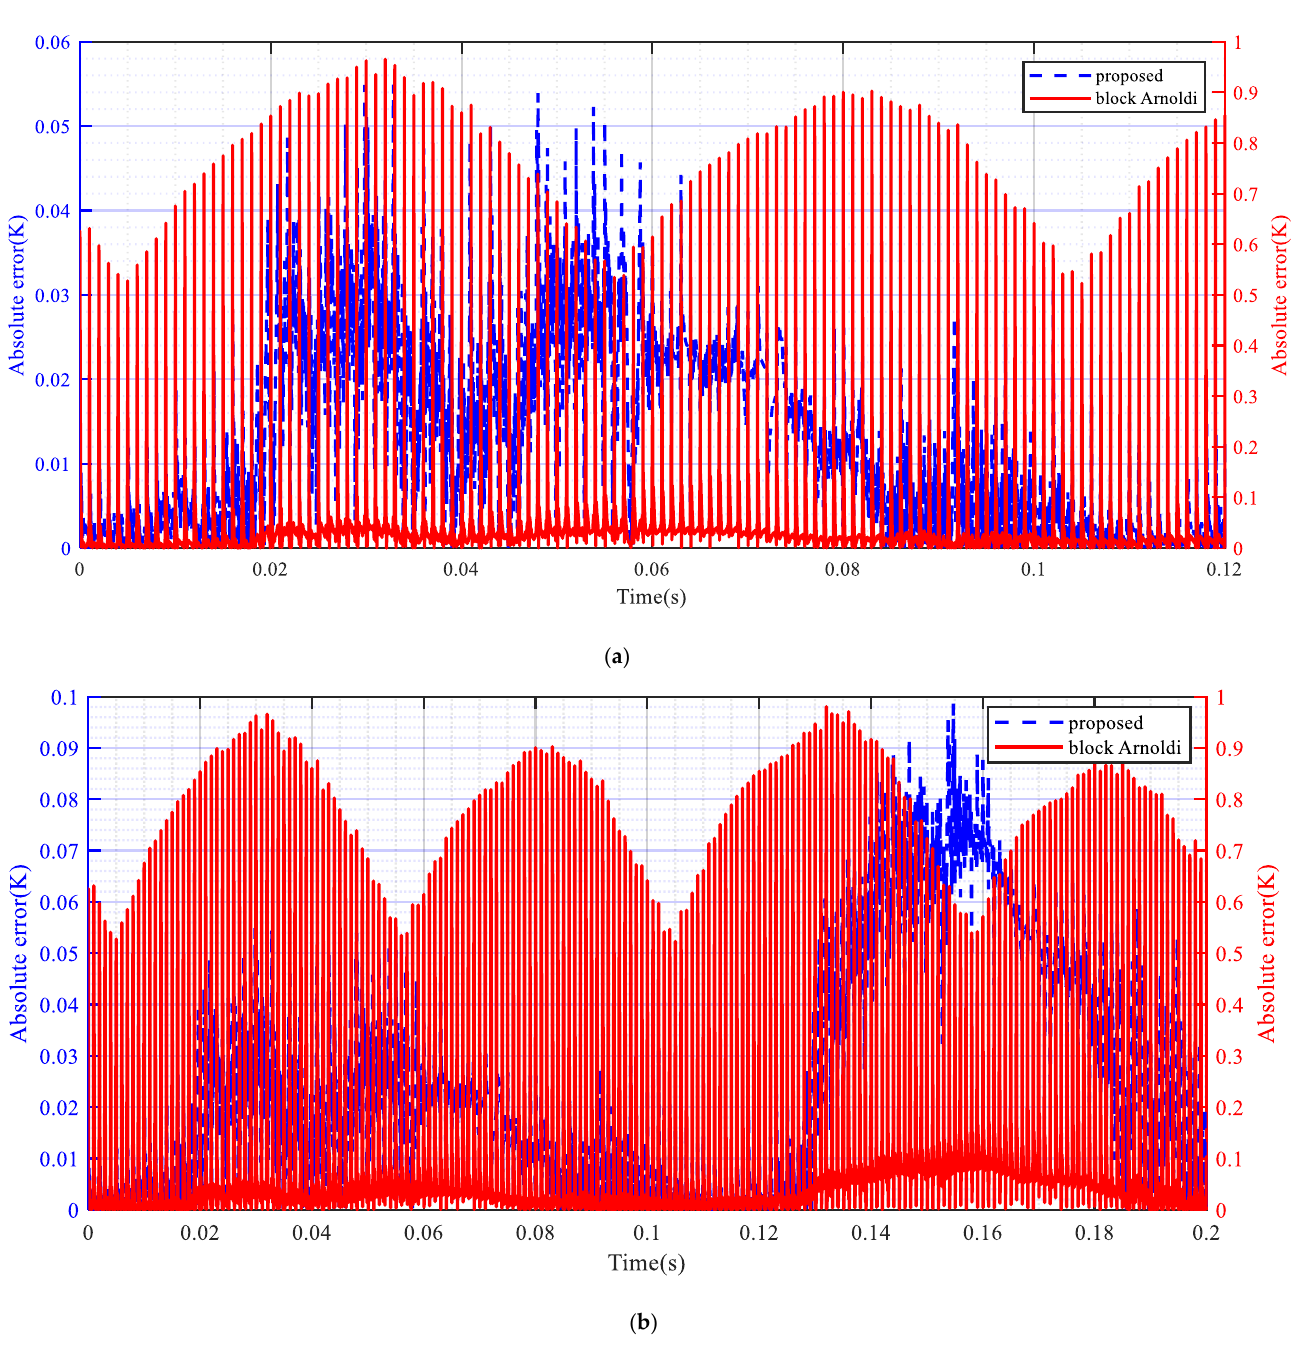
Figure 8. Absolute errors of the computed temperatures on observing point 2, using the conventional block Arnoldi algorithm and the proposed scheme, compared to those of the original NTM model under the tested broad-frequency-excitation signal. ( a ) Zoom in (0 – 0.12 s). ( b ) Whole excitation duration (0 – 0.2 s).